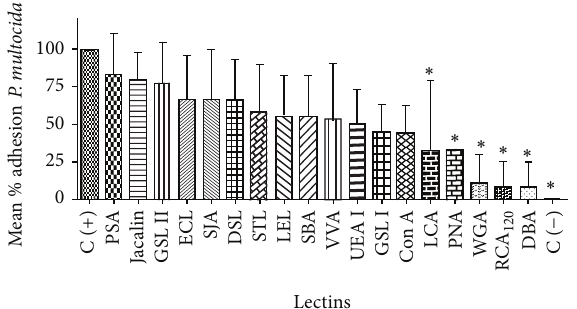
Figure 2: Inhibition of P. multocida adhesion to the ciliated respiratory epithelium of rabbit fetuses exposed to various lectins. Adhesion is expressed as mean percentage of the ciliated border epithelium coated by adhered bacteria. ∗ Significant inhibition ( 𝑃 < 0.05 ) compared with the positive control tissues. C ( − ): negative